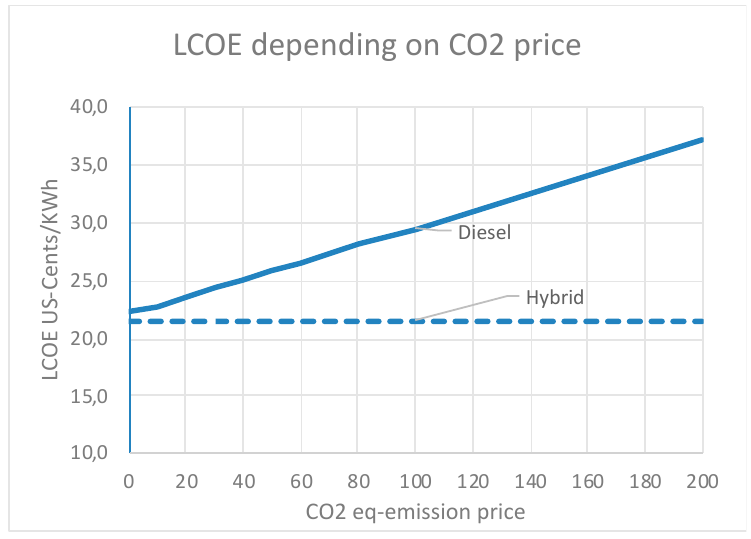
Figure 3. Levelised cost of energy depending on CO 2 -eq price (socioeconomic calculation).